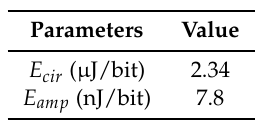
Table 3. Energy consumption of XBee S2C per bit when d = 100 m.